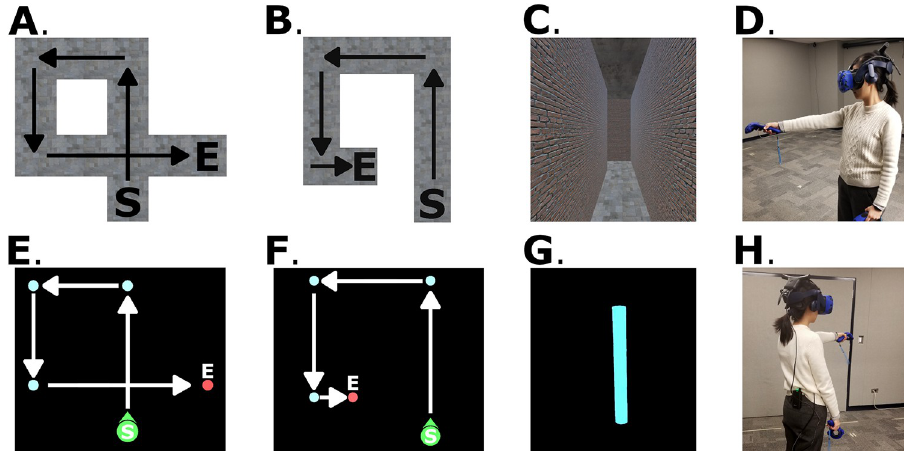
Fig 2. Example paths in Experiment 1 for the (A) hidden intersection cross (HI-C), (B) no intersection no cross (NI-NC), (E) pole-guided cross (PG-C), and (F) pole-guided no cross (PG-NC) conditions. C & G show the participant’s perspective from within the virtual environment (brightness adjusted for illustration purposes). D & H show apparatus and the testing room. S: Start. E: End. Arrows indicate the walking direction.